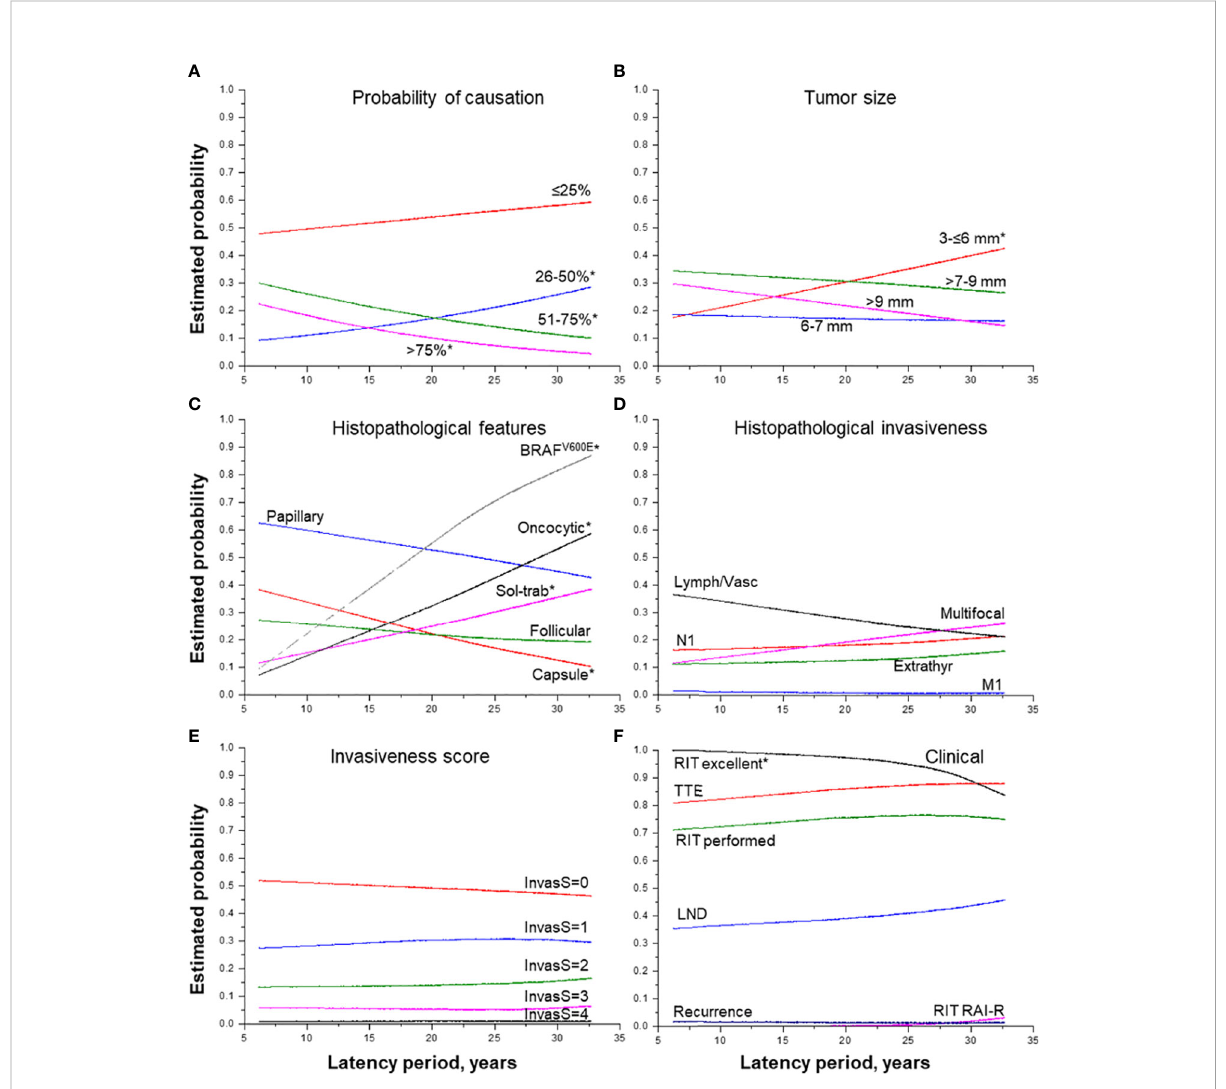
FIGURE 2 Effect of the period of latency on MPTC characteristics. (A) probability of causation (by 25%), (B) tumor size (by groups), (C) histopathological features, (D) histopathological features of tumor invasiveness, (E) the integrative invasiveness score, and (F) clinical parameters. RIT, radioiodine therapy; TTE, total thyroidectomy; LND, lymph node dissection; RAI-R, radioiodine-refractory. * indicate statistical signi fi cance, p <